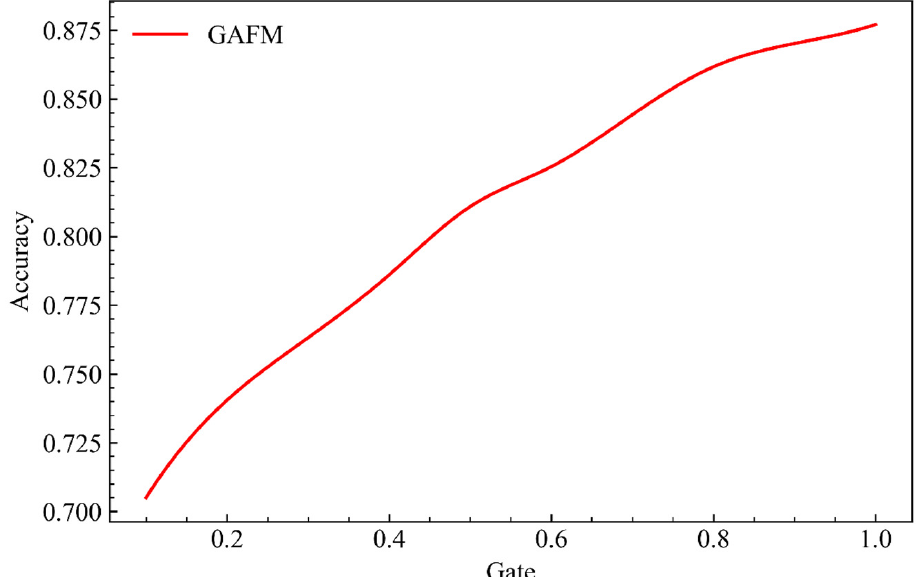
Figure 9. Prediction accuracy of GAFM under the influence of g.